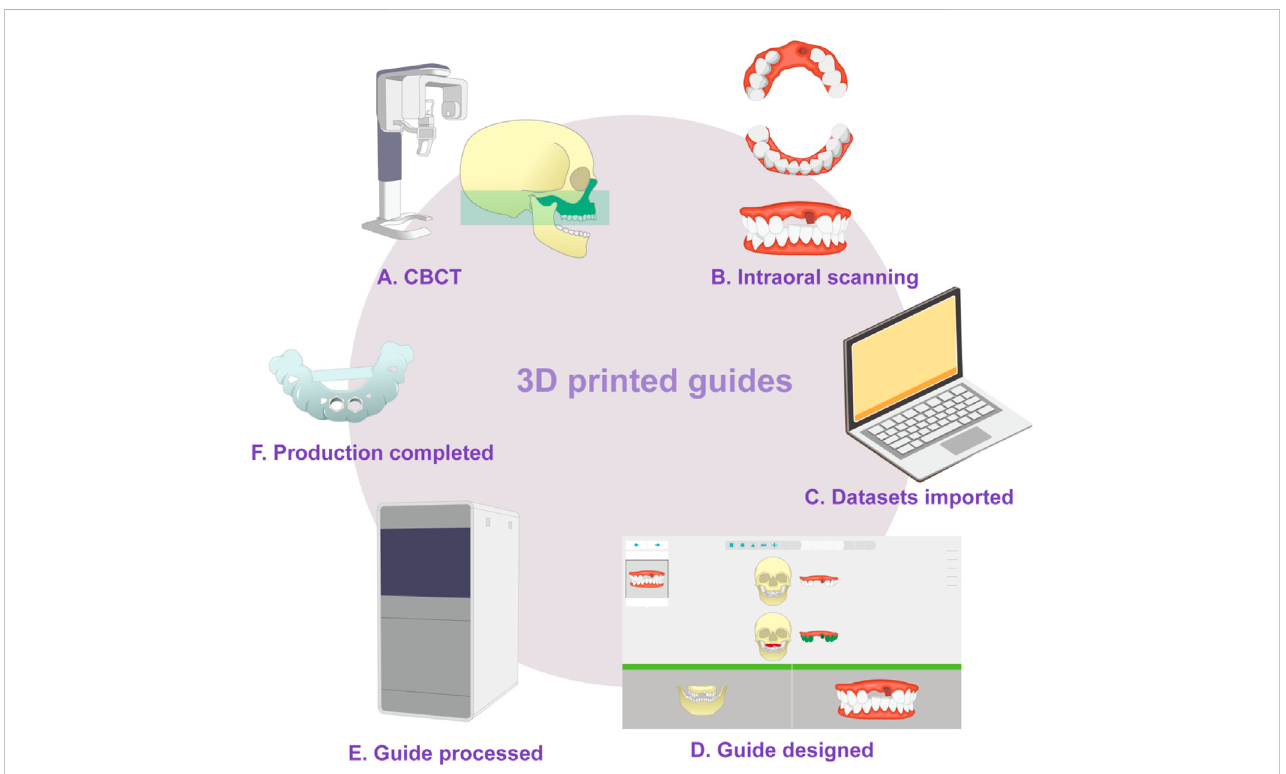
FIGURE 3 Schematic diagram of guide production. (A) Cone-beam computed tomography is used to generate 3D data from the teeth and jaws. (B) Three- dimensional informationfromtheteeth andsurrounding softtissue isobtained byintraoral opticalimpressionorscanned fromatraditionalplaster model. (C) In the guide design software, the two datasets are imported in turn and then matched, checked, and con fi rmed. (D) The guide is designed. (E) 3D printing is used to fabricate the guide. (F) The fi nal guide is